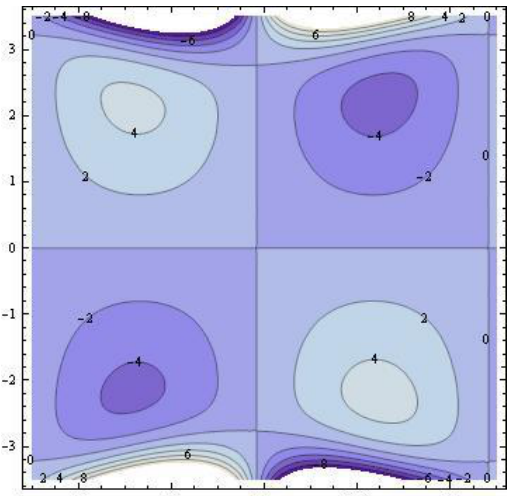
= 0.1 . Figure 19(b). Stream lines for 𝔼 1